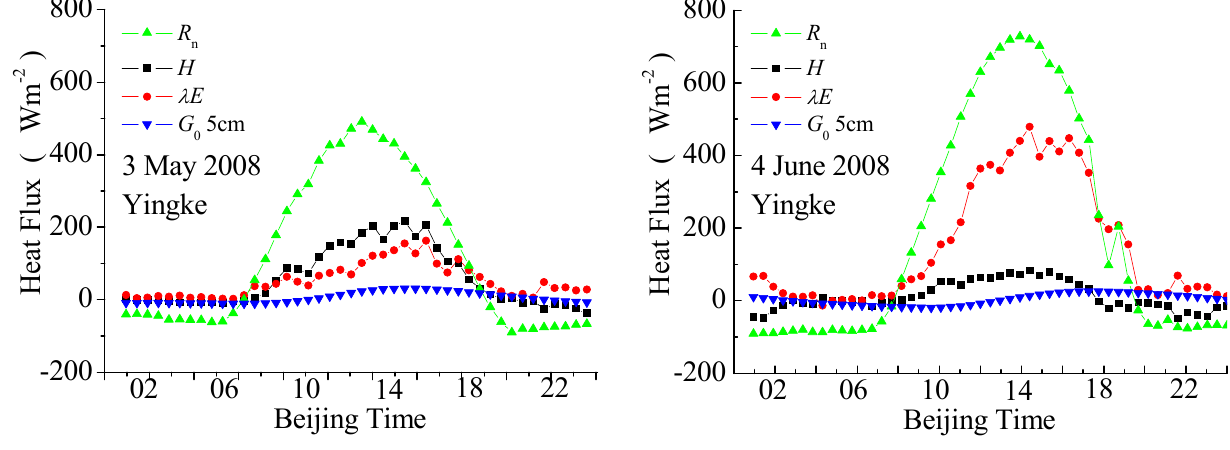
Fig. 3. Diurnal variations of land surface heat fluxes over the WATER area. Note: the soil heat flux is measurements at 5cm below the land